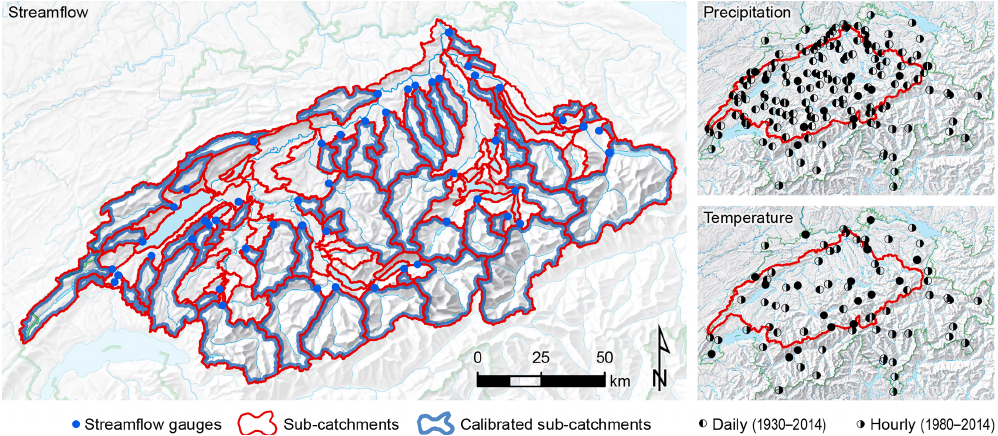
Figure 1. Overview map of the Aare River basin, showing data series available for streamflow (left panel), precipitation (top-right panel) and temperature (bottom-right panel). The streamflow map also reveals the 80 sub-catchments used in hydrological modelling and which of these were calibrated. Map background: Federal Office of Topography